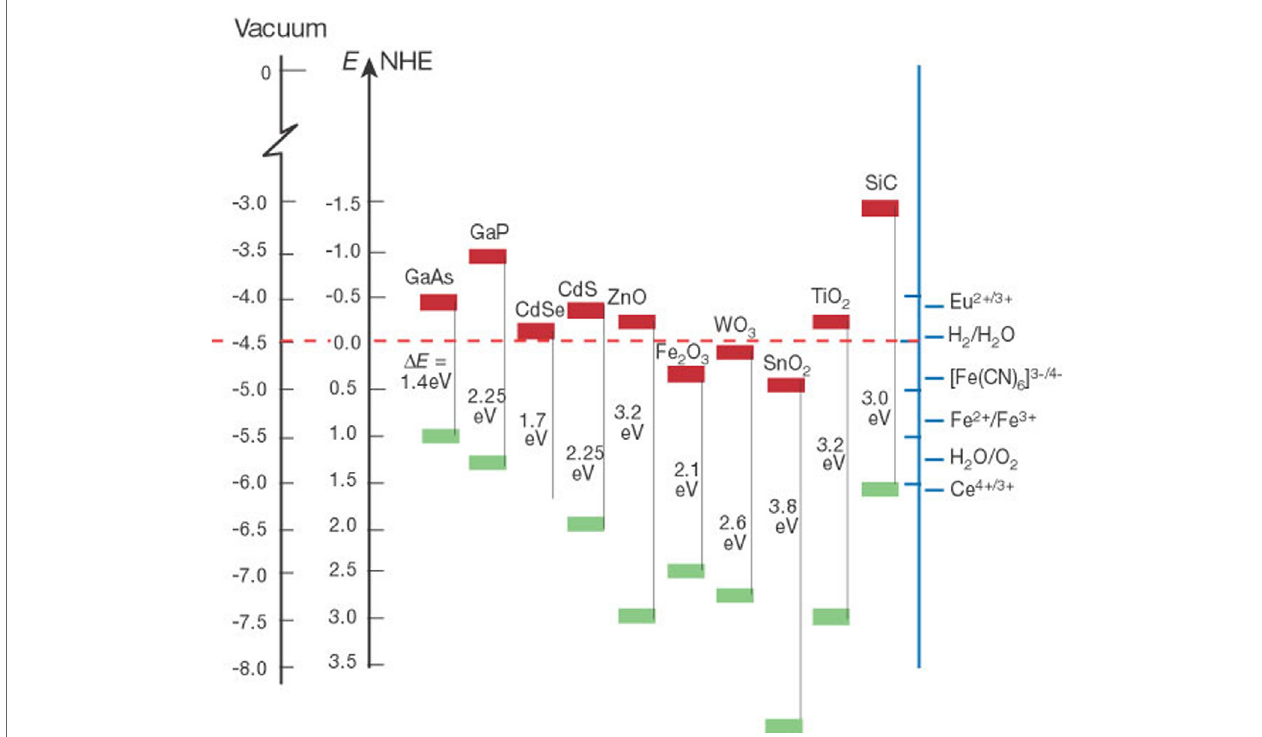
FiGURe 5 | The band positions of several semiconducting materials in aqueous electrolyte at pH = 1 . The red dash line is about the work function of graphene (Gratzel, 2001). Copyright Nature Publication Group,